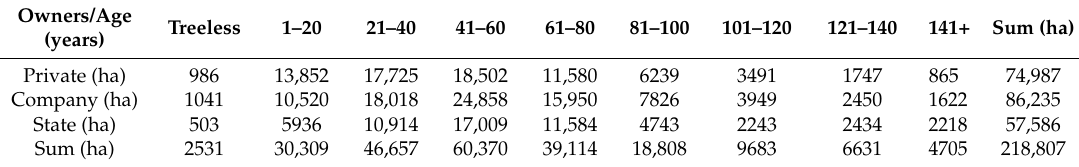
Table 1. Ownership and age class distribution of forests in Ilomantsi.